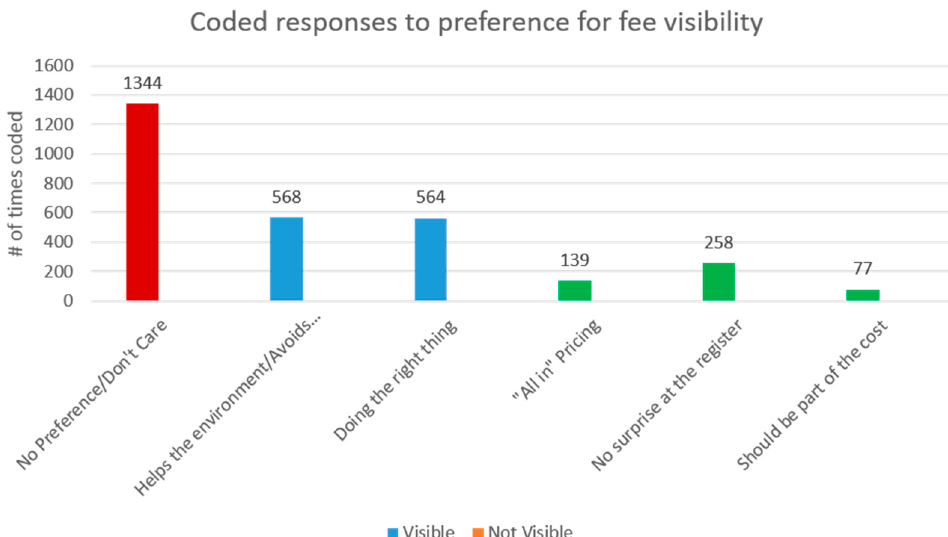
Figure 3. Coded responses to preference for fee visibility.